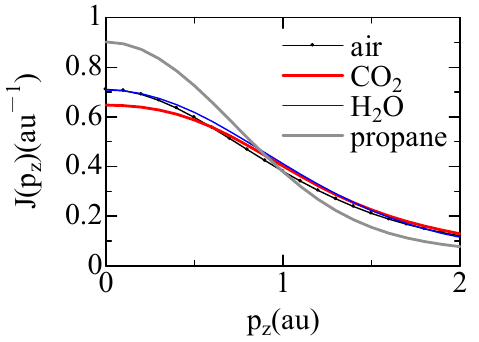
Figure 4. Theoretical Compton profiles of propane, CO 2 , H 2 O, and air by crystal code, in which the molecular axis is spherically averaged. The Compton profiles are normalized to have a unit area.